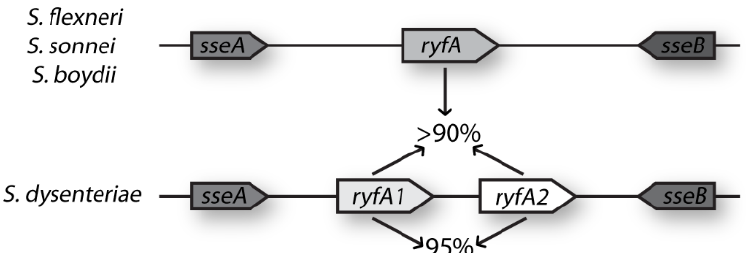
Figure 1. S. dysenteriae encodes for two nearly identical RyfA molecules, sibling small regulatory RNAs (sRNAs) here designated RyfA1 and RyfA2. RyfA1 and RyfA2 represent putative sibling sRNAs 95% identical to one another and with greater than 90% nucleic acid identity to the singlet RyfA encoded at the same chromosomal location in all other species of Shigella as well as several isolates of E. coli .